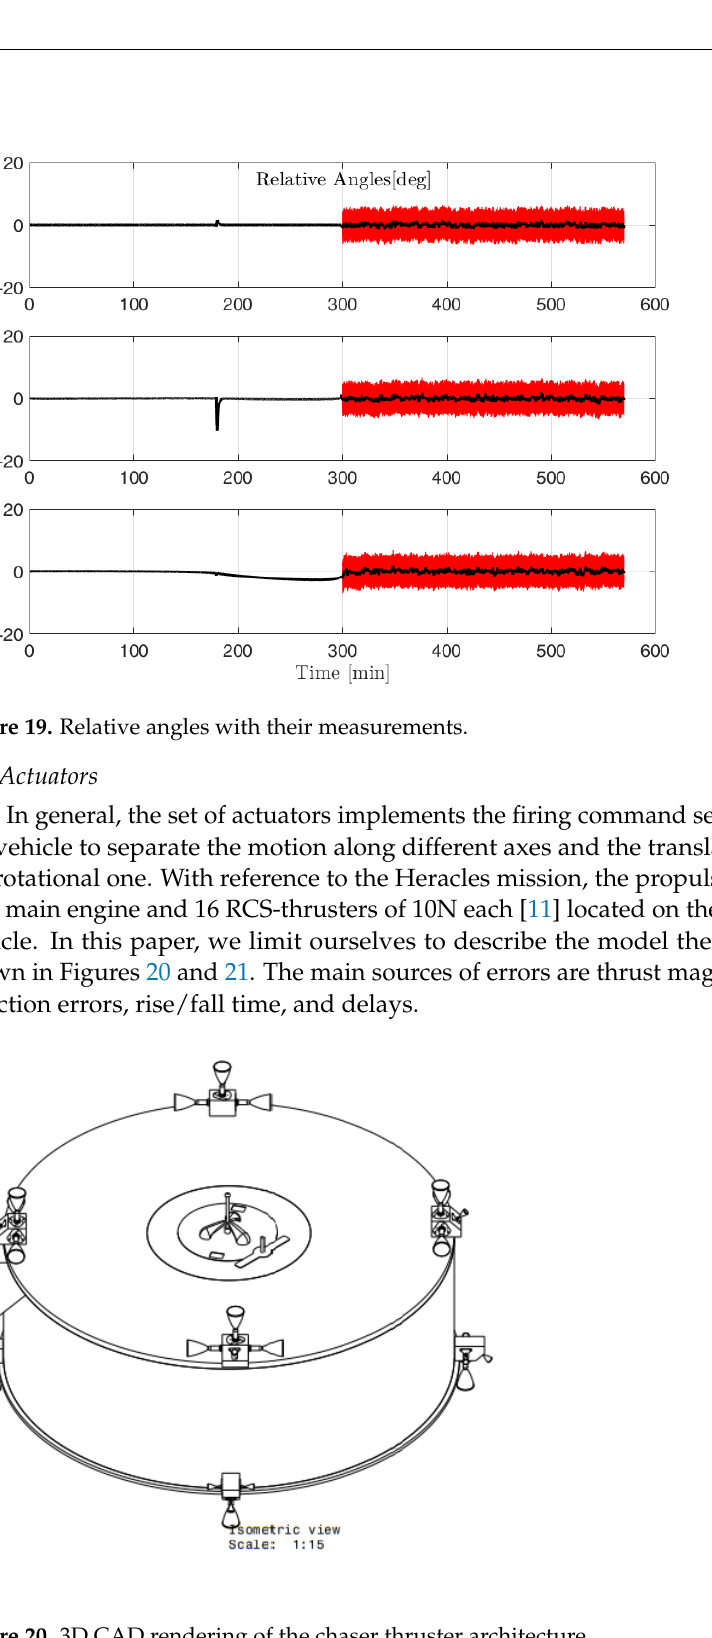
Figure 20. 3D CAD rendering of the chaser thruster